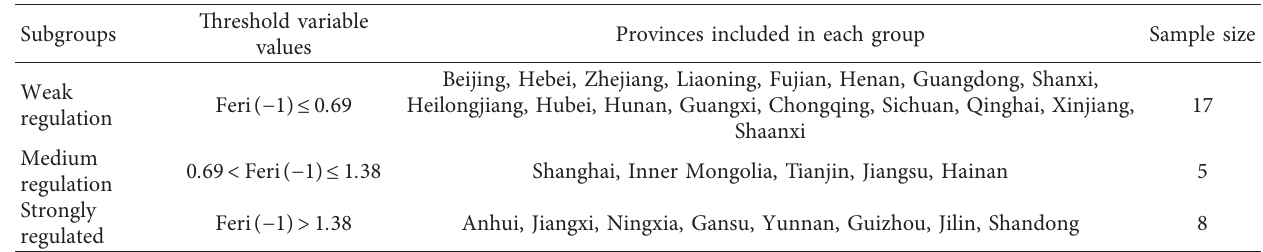
Table 8: Results of sample grouping based on threshold values.